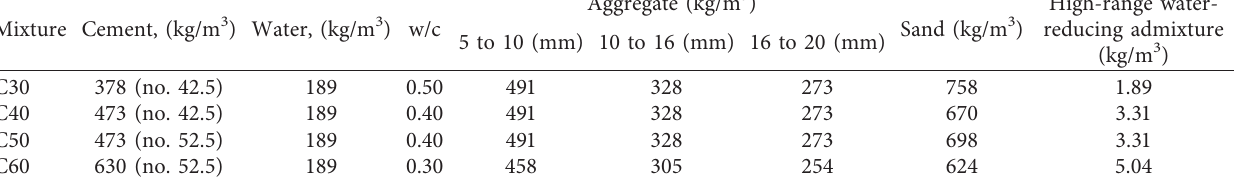
Table 4: Concrete mixture proportion.